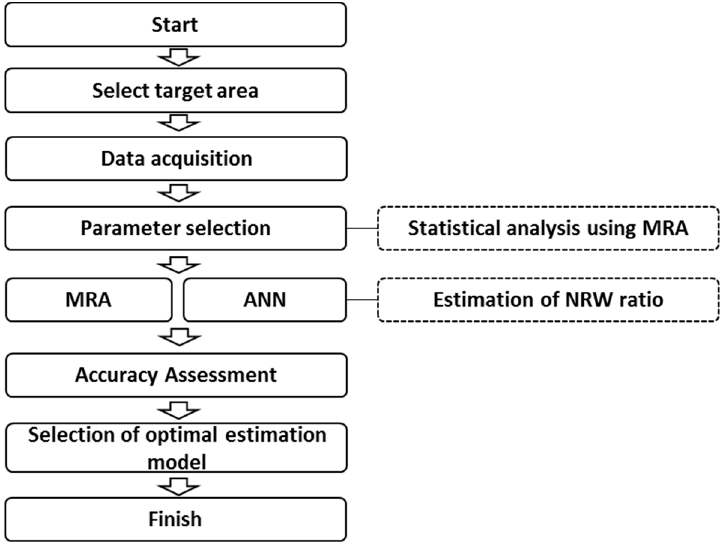
Figure 2. Study Diagram. Multiple regression analysis (MRA); artificial neural network (ANN).